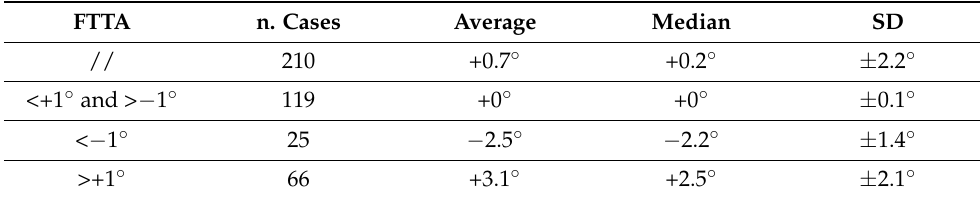
Table 1. FTTA values. FTTA n.